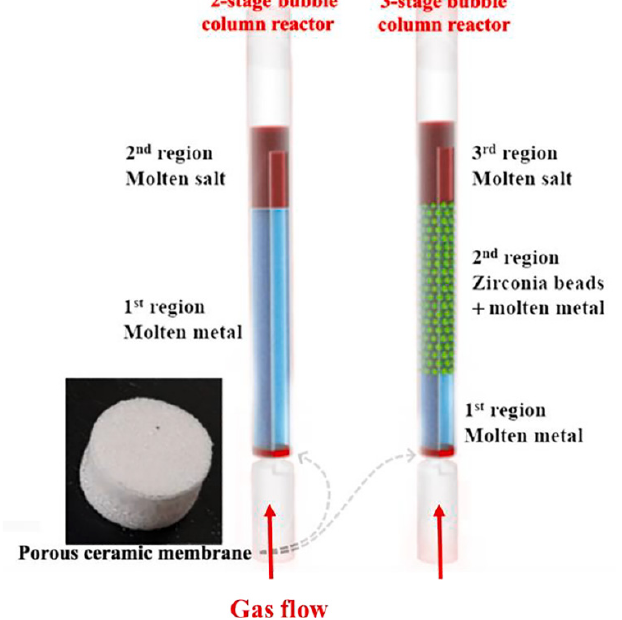
Figure 3. The structures of the two-stage and three-stage bubble-column reactors implemented for methane decomposition reaction. (Copied from Ref. [43] with Elsevier permission).